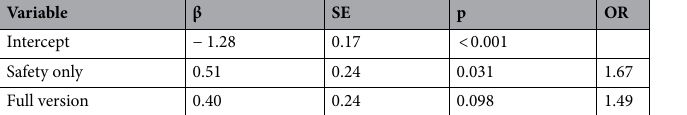
Table 4. Logistic regression of intervention condition on whether participants spoke with others about the